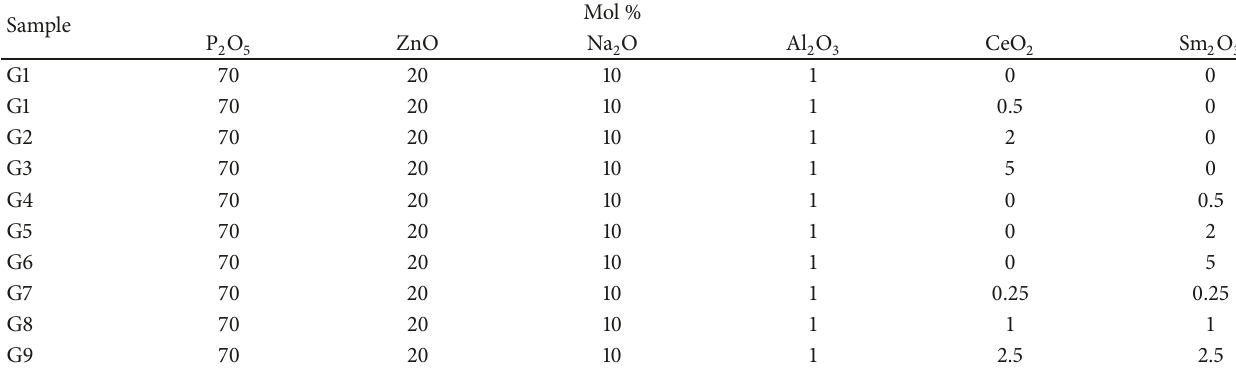
Table 1: Chemical composition of the prepared